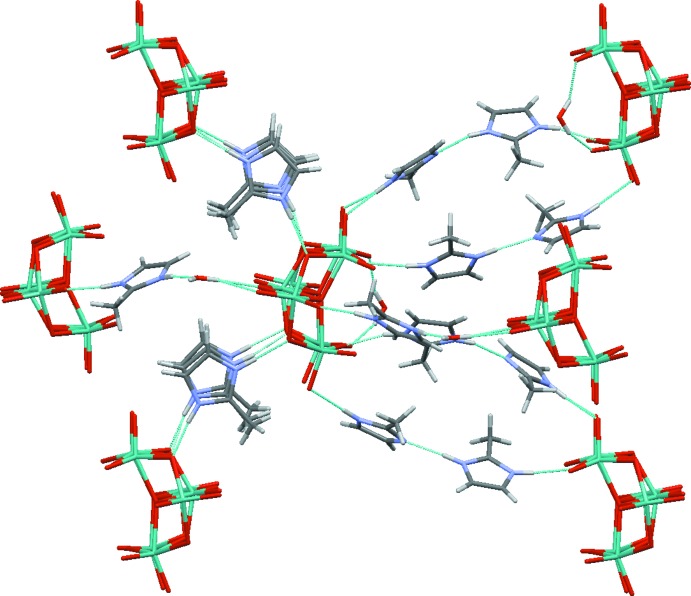
Detail of the structure of (I) showing the inter­connections of the [Mo7O24]6− anion with its neighbours.